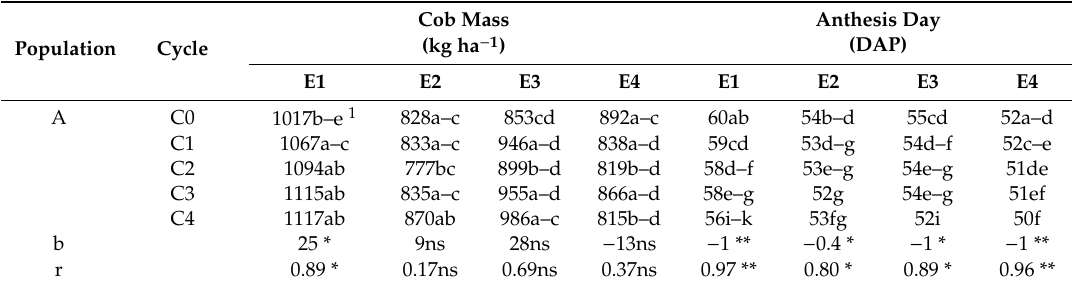
Table A2. Means for cob mass and anthesis day of (A–E) five populations and (C0–C4) five cycles evaluated in four